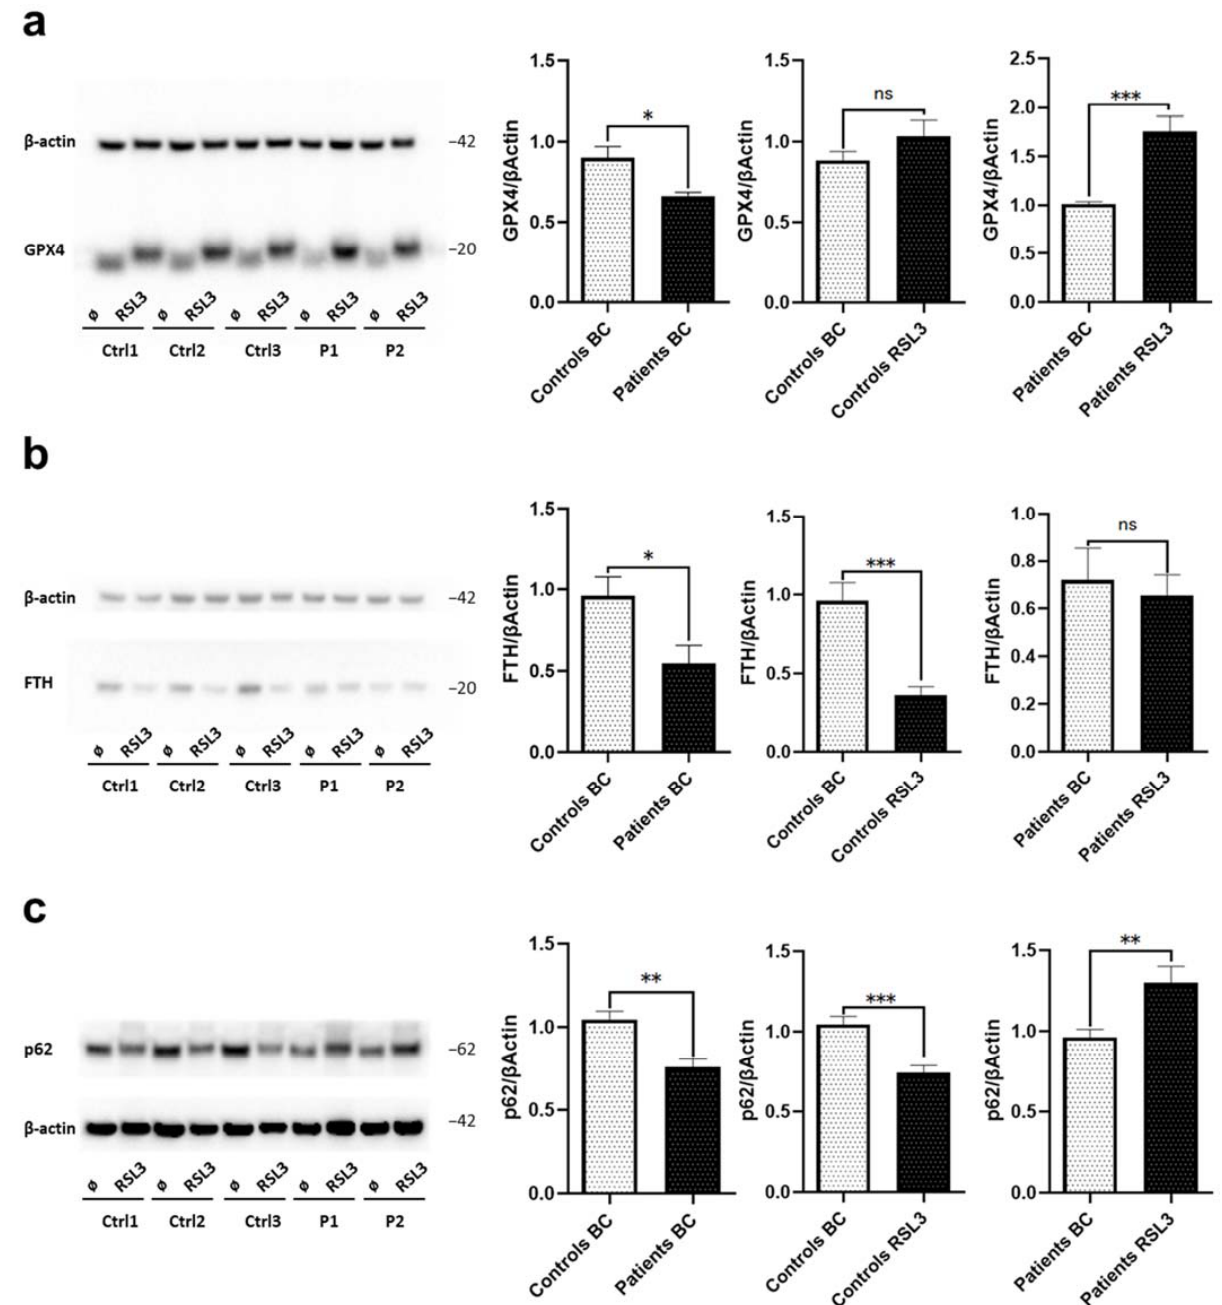
Figure 4. Loss of WDR45 is linked to disrupted iron recycling via ferroptosis. Western blot analysis of total protein extract from fibroblasts from: ( a ) Patients’ fibroblasts (P1, P2) and three healthy controls (Ctrl1, Ctrl2, Ctrl3) with antibodies against GPX4 and β‐ actin (loading control) under basal conditions and upon treatment with 1.5 μ M of RSL3 for 6 h. ( b ) WDR45 mutation carriers (Patients, P1 and P2) and three healthy controls (Ctrl1, Ctrl2, Ctrl3) with antibody against FTH and β -actin (loading control) under basal conditions and upon treatment with 1.5 μ M of RSL3 for 6 h. ( c ) Patients’ fibroblasts and three healthy controls with antibodies against p62 and β‐ actin (loading control) under basal conditions (BC) and upon treatment with 1.5 μ M of RSL3 for 6 h. Data analysis was carried out for all Western blots with Ctrl1 in basal conditions set as 1 (first and second diagrams) or P1 in basal conditions (third diagram). The error bars indicate the standard error of the mean of n ≥ 3 independent experiments. Statistical significance was analyzed by Unpaired t -test (ns refers to p ≥ 0.05 (not significant); * p < 0.05; ** p < 0.01; *** p <